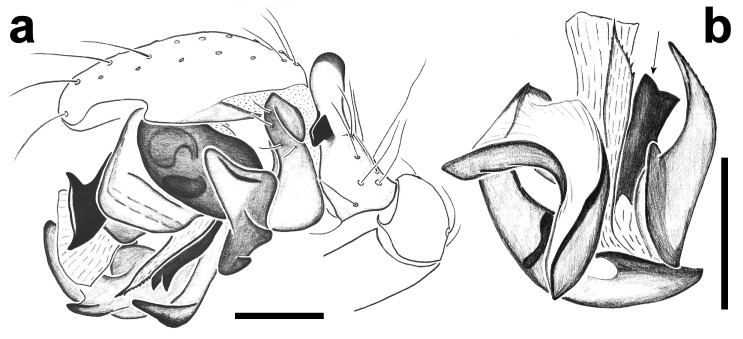
Agyneta
orites (Thorell, 1875). a: left male palp, retrolateral, scale = 0.2 mm; b: left embolic division, ventral, scale = 0.2 mm.